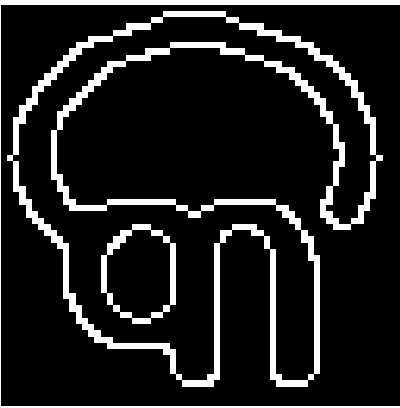
Figure 9. Final preprocessed image contour.